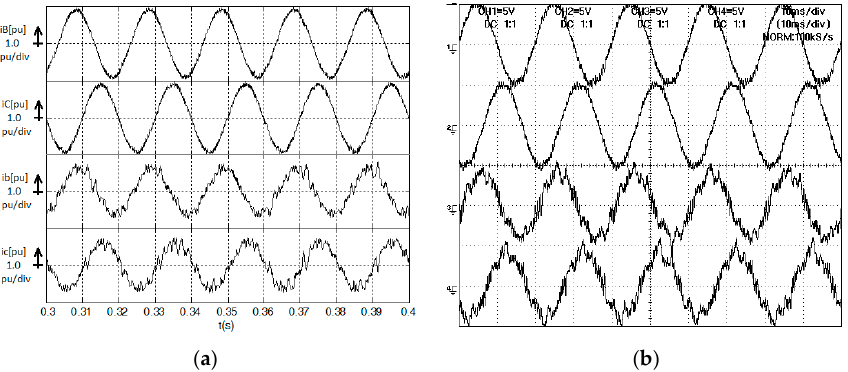
Figure 8. Active and reactive power response and line currents for a P and Q step Δ P Ref = +0.4 pu and Δ Q Ref = +0.2 pu). ( a ) Simulation Results; ( b ) Experimental results, Ch1 = Ch2 = 0.5 pu/div ( P Series and Q Series) and Ch3 = Ch4 = 1.0 pu/div (iB and iC).